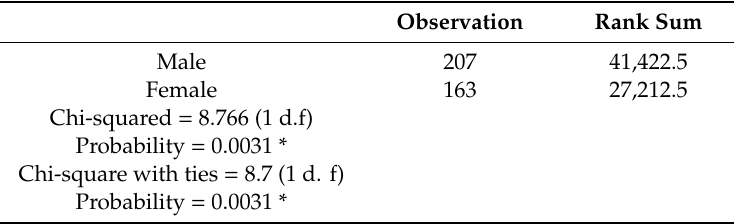
Table 5. Kruskal-Wallis Equality-of-Populations-Rank